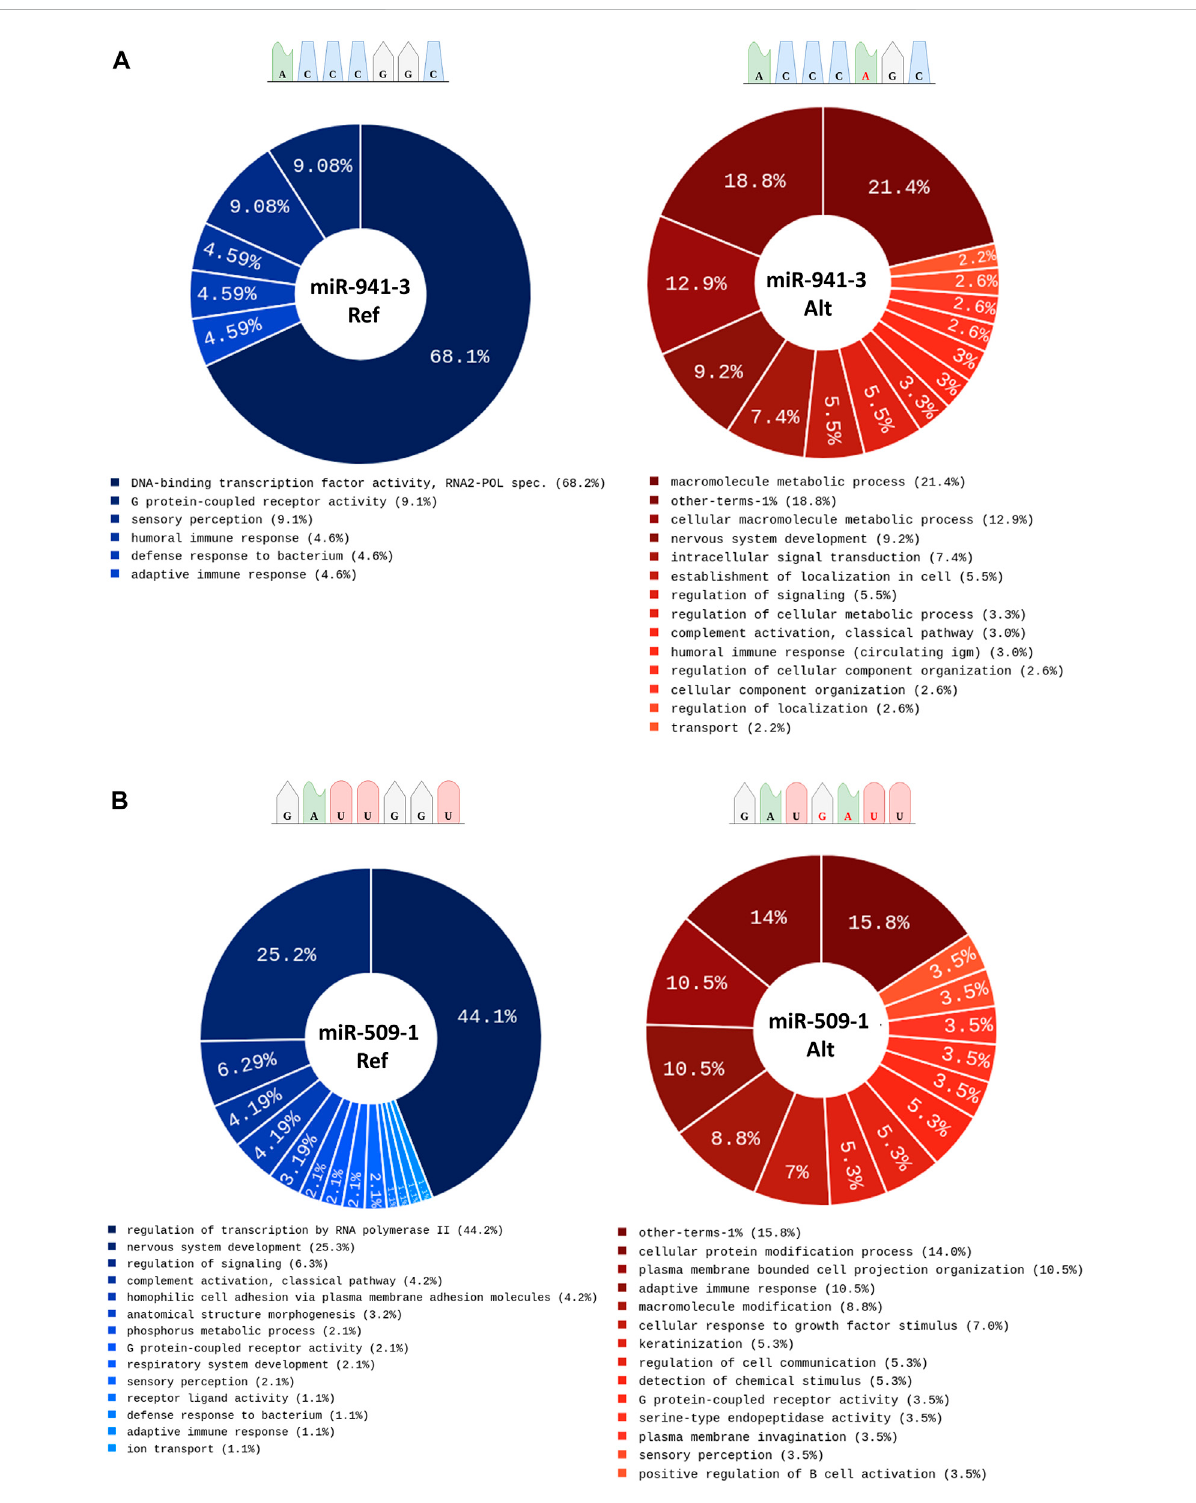
FIGURE 4 OverRepresentationAnalysisperformedontargetgenespredictedforthereferenceandthealternativevariantinthemiRNAseedsequencefor (A) miR-941-3 and (B)